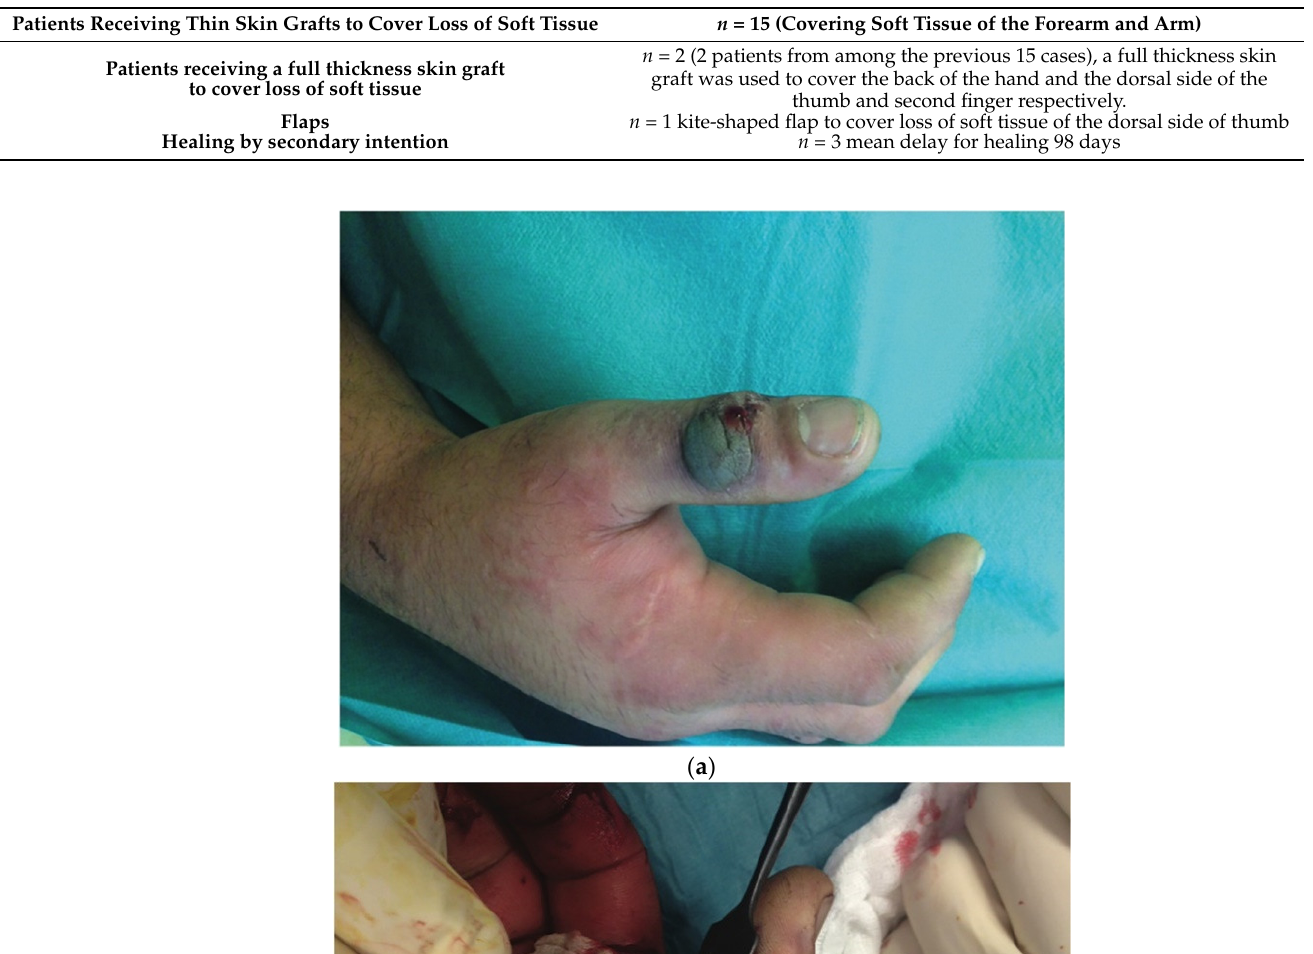
Table 4. Reconstructive surgery.